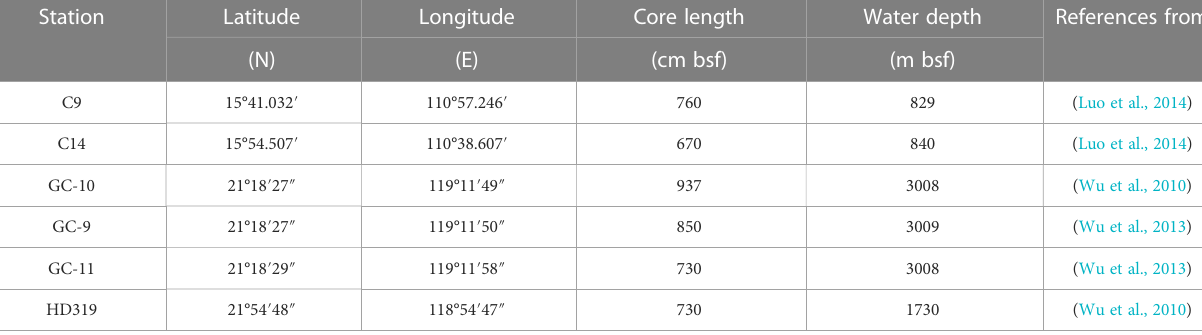
TABLE 1 Coordinates, water depth and core length at the sediment stations sampled on the northern South China Sea; bsf is below sea fl